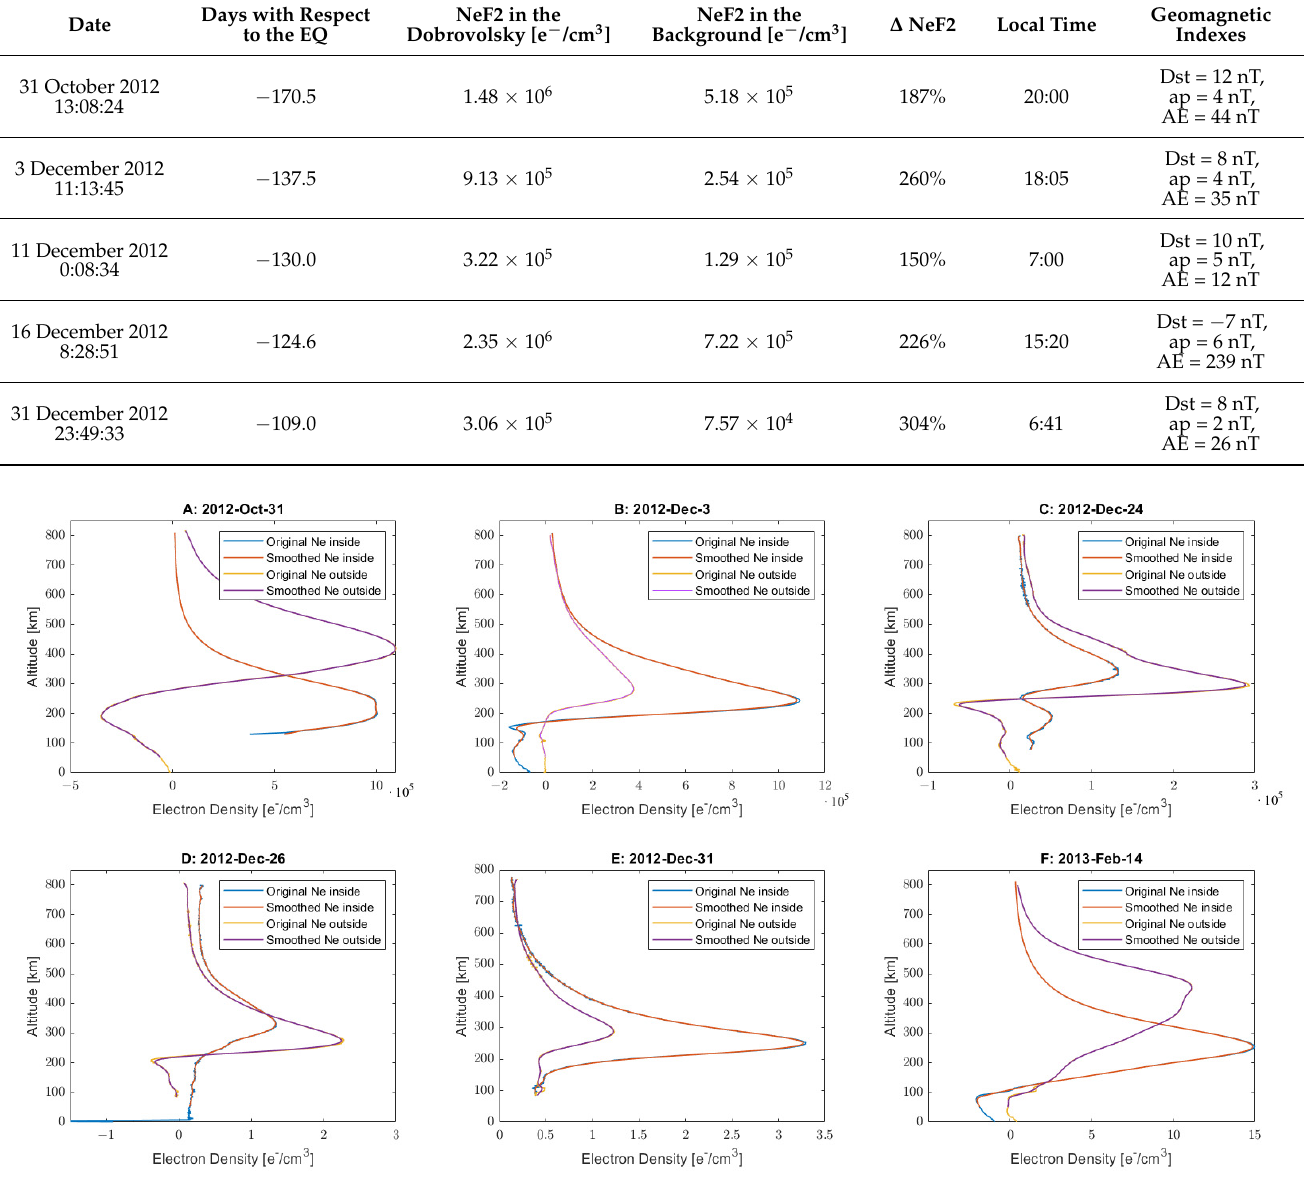
Figure 22. Electron density profiles inside and outside the Dobrovoslky area for the most anomalous days depicted in the time series, i.e., 31 October 2012 ( A ), 3 December 2012 ( B ), 24 December 2013 ( C ), 26 December 2013 ( D ), 31 December 2012 ( E ), and 14 February 2013 ( F ).